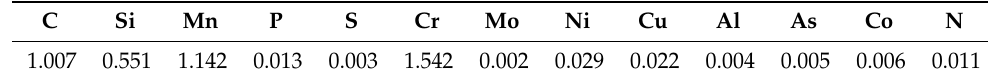
Table 2. Chemical composition of the grinding roller material.